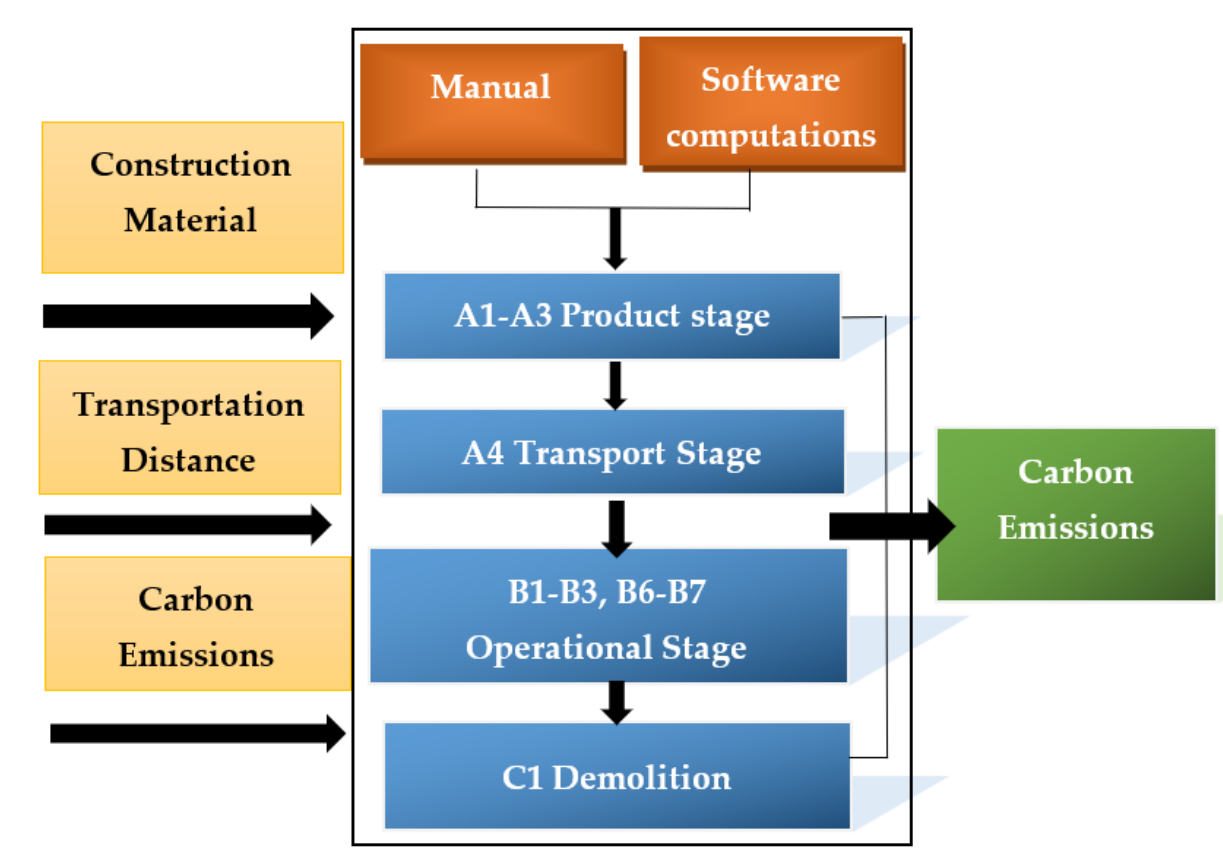
Figure 2. System boundaries of unit processes.